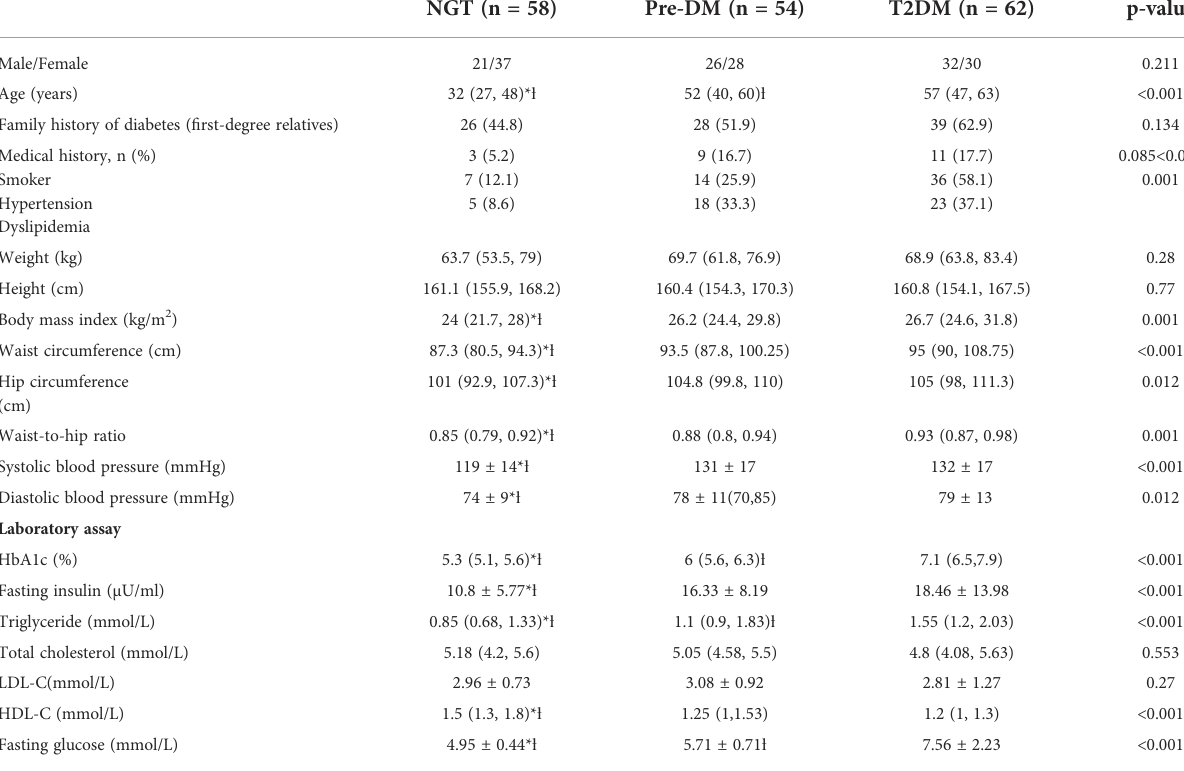
TABLE 1 Clinical characteristics of subjects with NGT, pre-DM, and